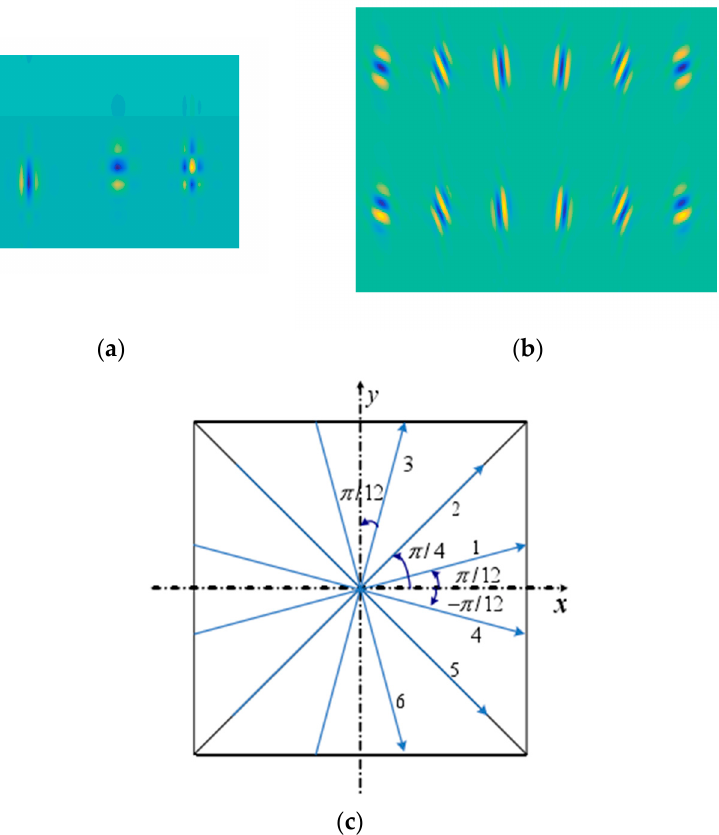
Figure 2. 2D discrete wavelet and 2D DT complex wavelet: ( a ) Two-dimensional discrete wavelet; ( b ) Two dimensional DT complex wavelet; ( c ) The ideal directional distribution of a two-dimensional complex wavelet.